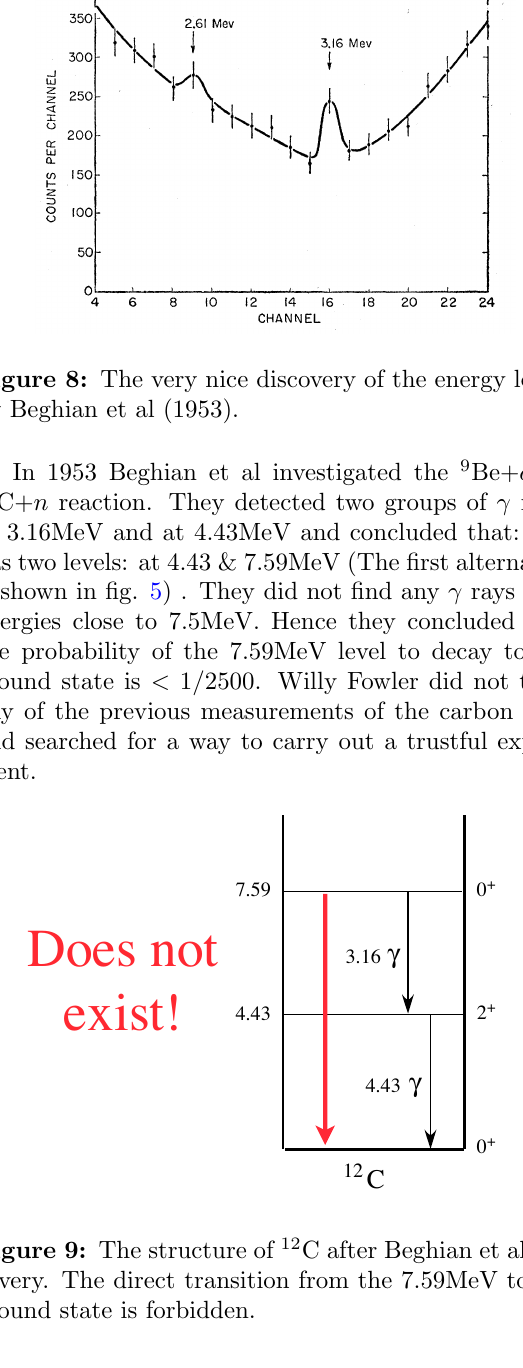
of  rays as discovered by Beghian et al. 1953.